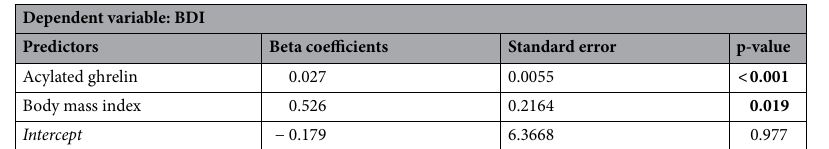
Table 5. Linear regression model for predictors of BDI among 49 postmenopausal women. R = 0.62, R 2 = 0.38, adjusted R 2 = 0.36, F (2,46) = 14.38, p < 0.0001. The model was adjusted for waist/hip ratio (p = 0.395). Bold values indicate statistical significance of p <